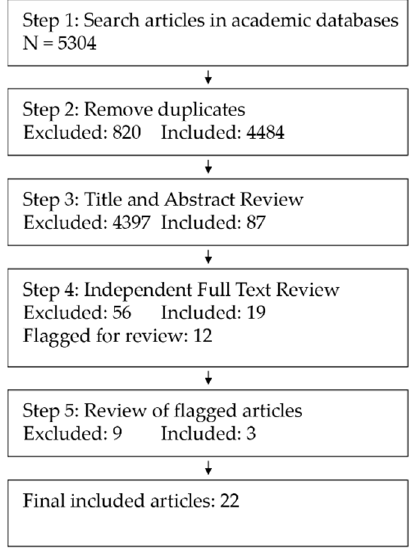
Figure 1. Diagram of the search process.